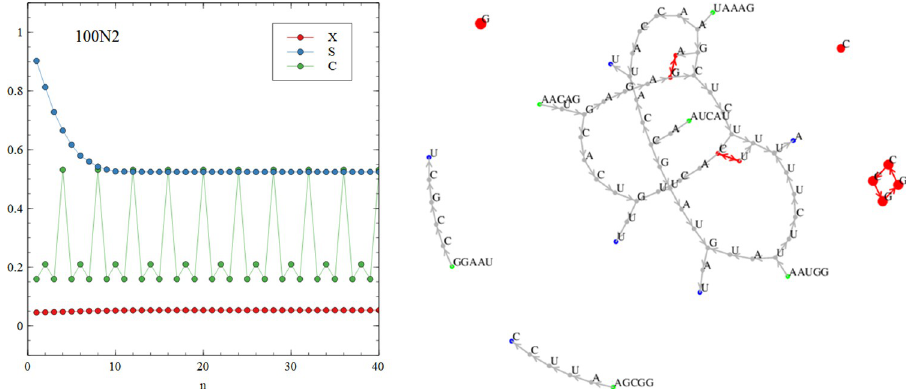
Fig 10. The graph functions and word graph for run 100N2 show the presence of cycles of period 1, 2 and 4.